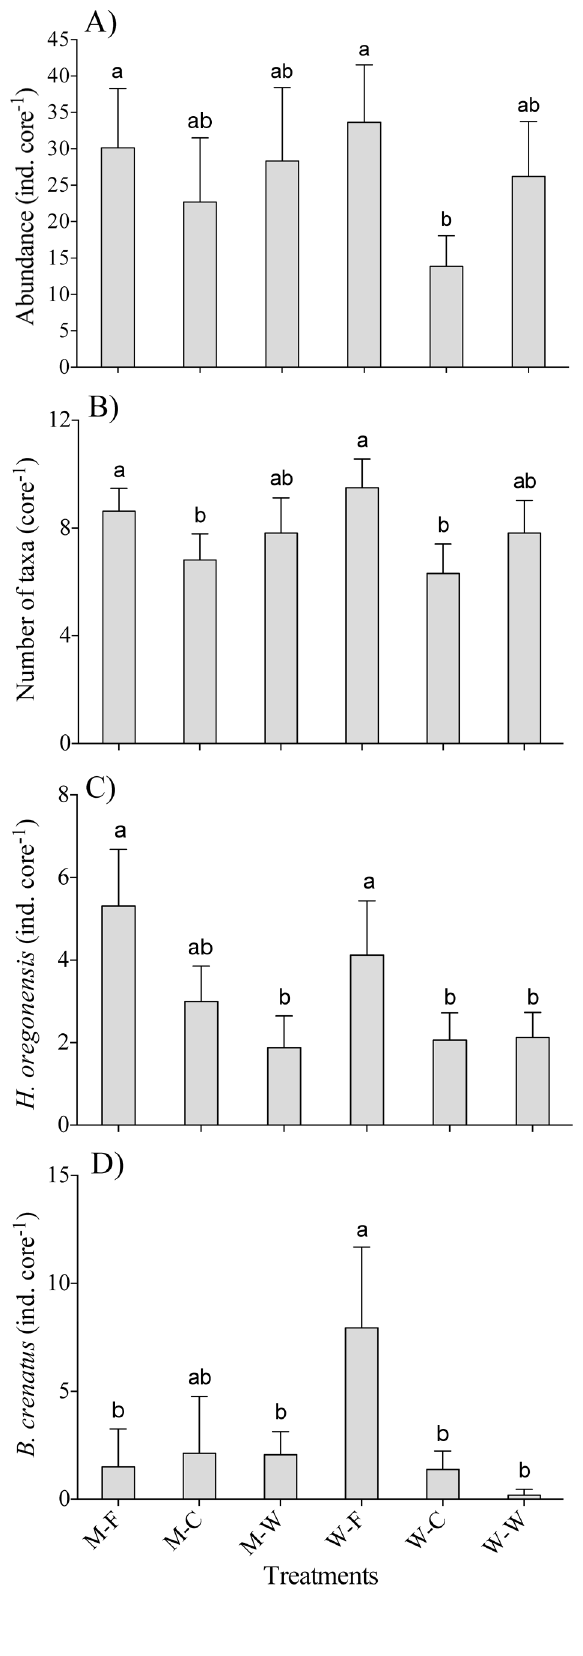
Fig. 3. Mean (A) abundance and (B) species richness (number of species) of macrofauna and abundance of (C) Hemigrapsus oregonensis and (D) Balanus crenatus (±SE, n = 16) from sediment. Treatments are combinations of presence (M) or absence (W) of Manila clams Venerupis philippinarum and anti-predator net status (F: fouled; C: cleaned; W: without). Different letters above bars indicate significant (p <0.05) differences between treatment levels based on a posteriori pair-wise comparisons